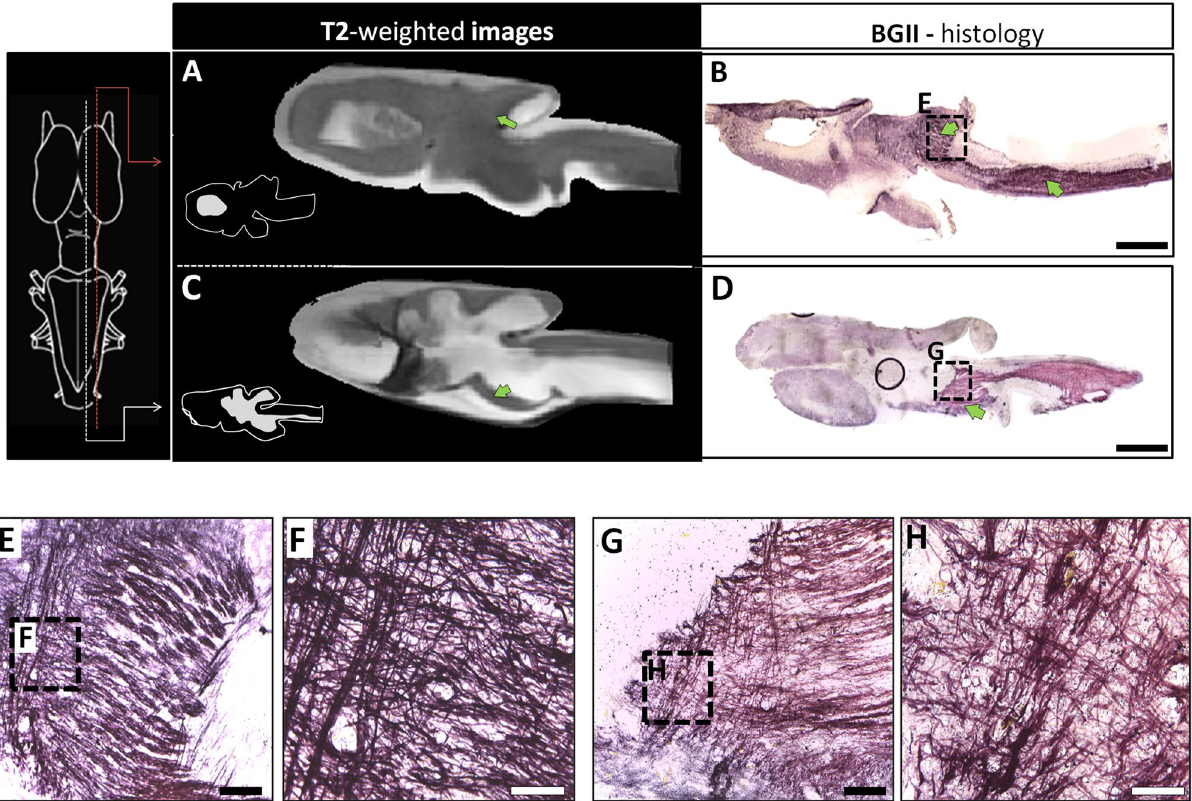
Figure 6. MRI and BGII techniques in the axolotl brain. ( A , C ) sagittal sections of in-vivo T2-weighted images and myelin staining with BGII; ( B , D ) the approximate myelin localization is indicated in the diagram on the left. Insets in ( A ) and ( C ) show diagrams of the corresponding sagittal plane. In the histological micrographs of BGII staining, ( E ) and ( G ) are amplifications of ( B ) and ( D ), while ( F ) and ( H ) are amplifications of ( E ) and ( G ), respectively. Bars in ( B ), ( D ) indicate 1 mm, in ( E ), ( G ) they indicate 100 μm, while in ( F , H ) they indicate 20